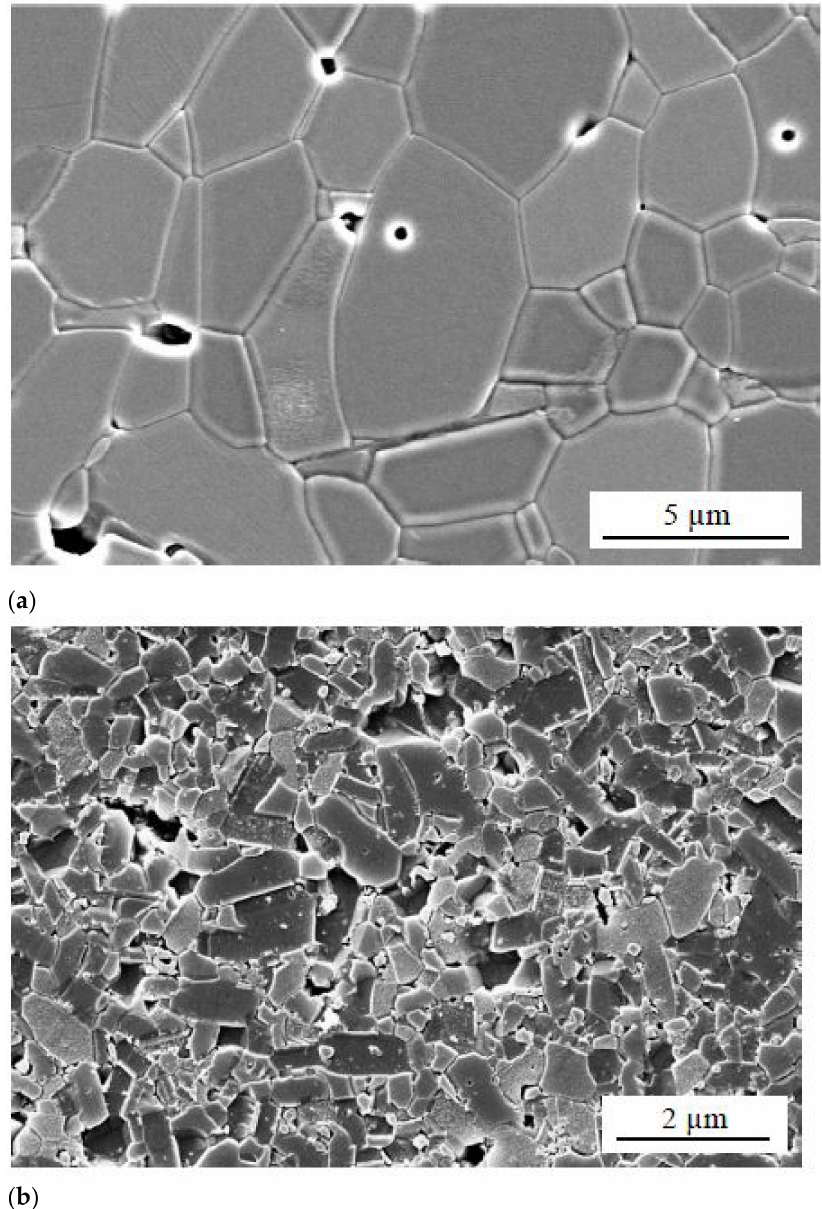
Figure 5. Microstructure of a polished surface of ( a ) alumina and ( b ) silicon carbide